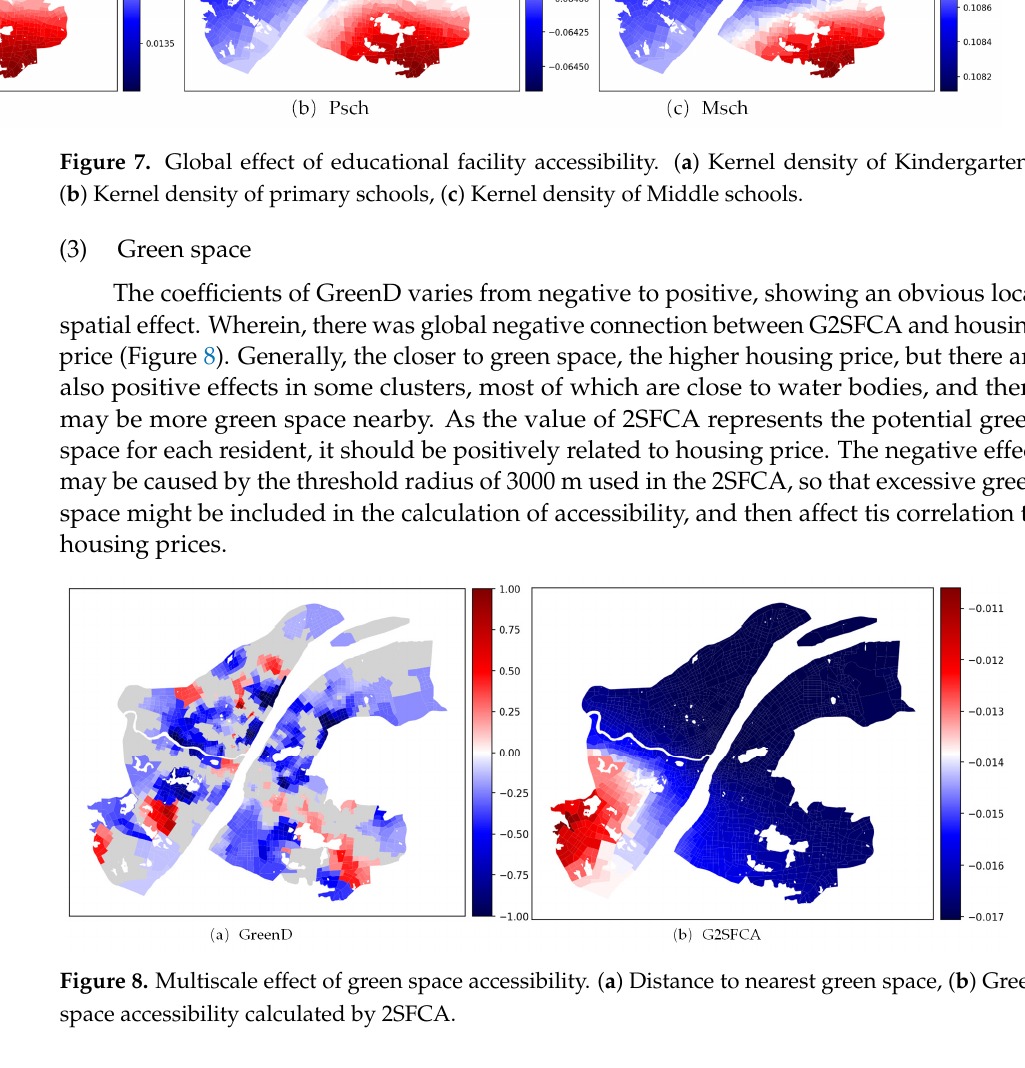
Figure 7. Global effect of educational facility accessibility. ( a ) Kernel density of Kindergartens, ( b ) Kernel density of primary schools, ( c ) Kernel density of Middle schools.